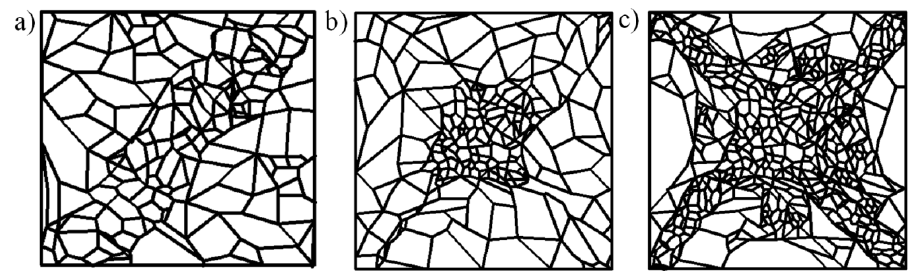
Figure 6. Internal grain size evolution of single-open MDF: ( a ) 3, ( b ) 6, ( c ) and 9 passes.